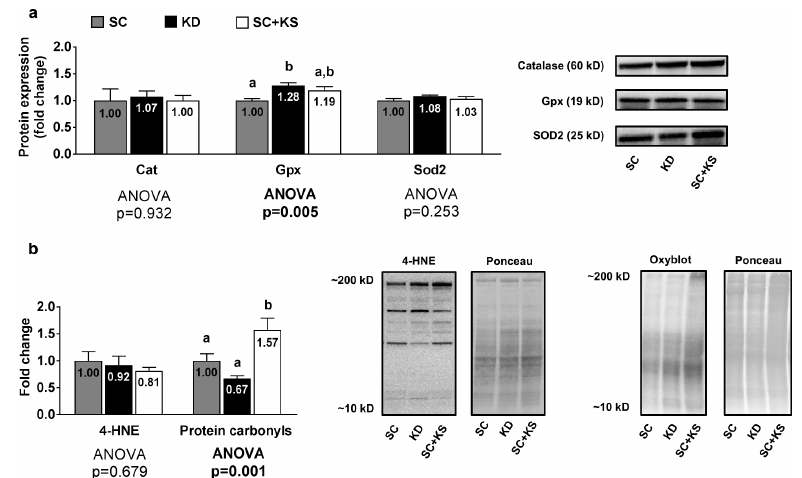
Figure 7. Liver oxidative stress-related proteins and markers in 8 month-fed rats. Legend: Liver catalase (Cat), glutathione peroxidase (Gpx), and mitochondrial superoxide dismutase (Sod2) protein levels are presented with representative images in panel ( a ). In panel ( b ), tissue 4-Hydroxynonenal (4-HNE), and protein carbonyls (Oxyblot) are presented with representative images. Fold-change for each protein are expressed relative to the SC group, all bars are presented as mean ± standard error values ( n = 7–8 per group), group means are indicated within each bar, ANOVA p -values are presented below data and different lettering (“a” versus “b”) indicates significant between-group differences whereas shared lettering (“a” as well as “b” or “a, b”) indicates lack of significant between-group differences. Abbreviations: SC, standard chow-fed rats; KD, ketogenic diet-fed rats; SC + KS, standard chow-fed rats with supplemental sodium